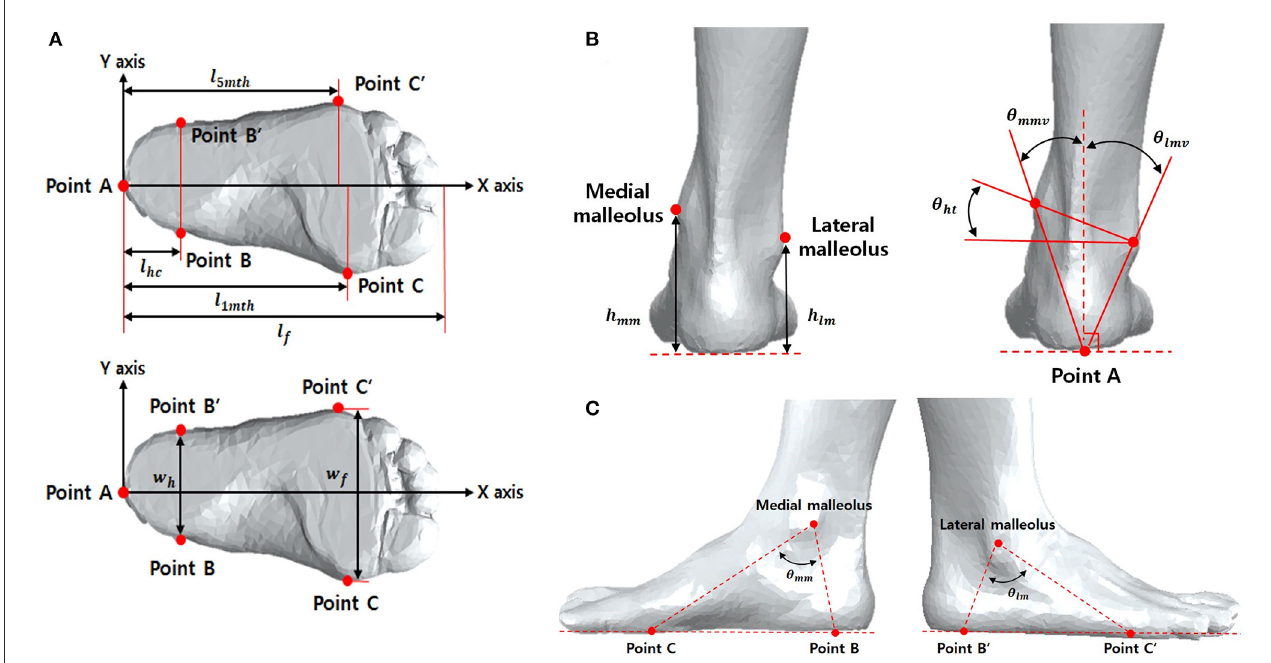
FIGURE1 Reference points for 3D ankle measurements in transverse plane (A) and frontal plane (B) , and sagittal plane (C) . l foot , length of foot; l 1 mt , length of 1st metatarsal head; l 5 mt , length of 5th metatarsal head; l hc , length of hind foot center; w h , width of hind foot; w f , width of forward foot; h mm , height of medial malleolus; h lm , height of lateral malleolus; θ mmv , vertical degree of medial malleolus; θ lmv , vertical degree of lateral malleolus; θ ht , degree of horizontal tilt; θ mm , degree of medial malleolus; θ lm , degree of lateral malleolus; θ mv , vertical degree of